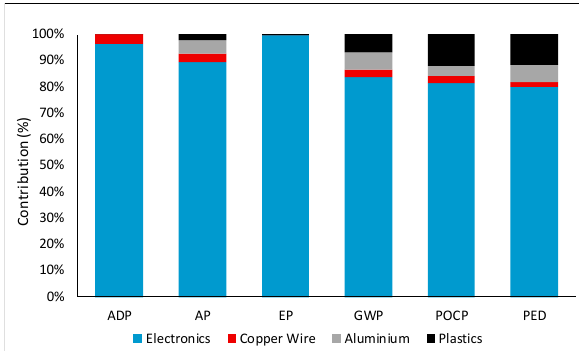
Figure 10. Percent contribution of the components of the module packaging to the result for each impact category.